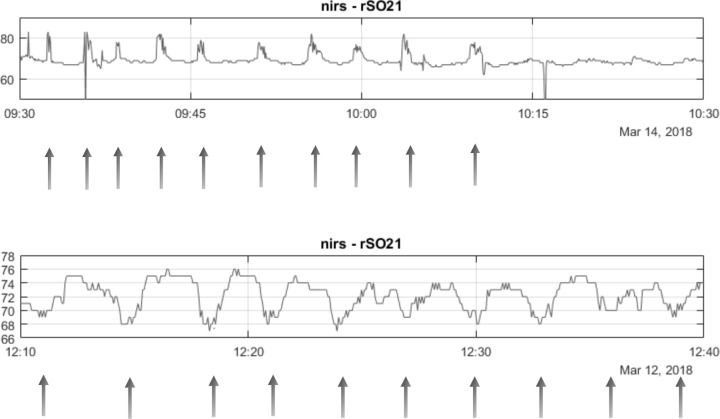
Schematic representation of NIRS occurring events.a: Rises in oxygen tissue saturation. b: Tissue desaturations.